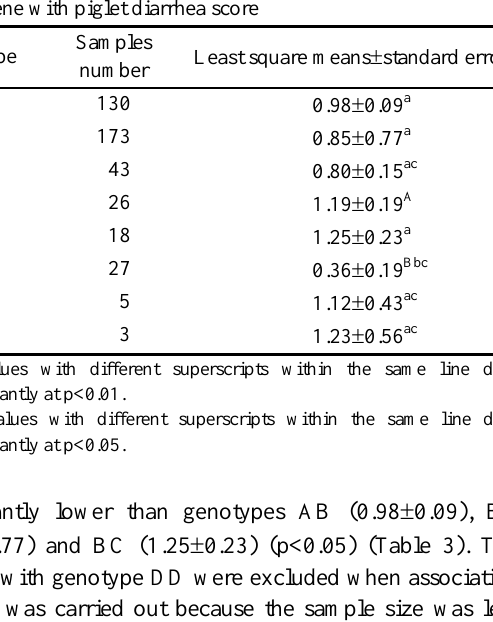
Table 3. Association of different genotypes of the exon 2 of SLA- DQA gene with piglet diarrhea score Samples Genotype